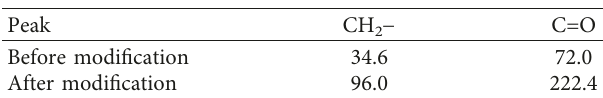
Figure 1: FT-IR spectra of SiC whiskers (a) before and (b) after surface modification. Table 1: Areas of CH � O peaks before and after modi- 2 − and C fication from calculated